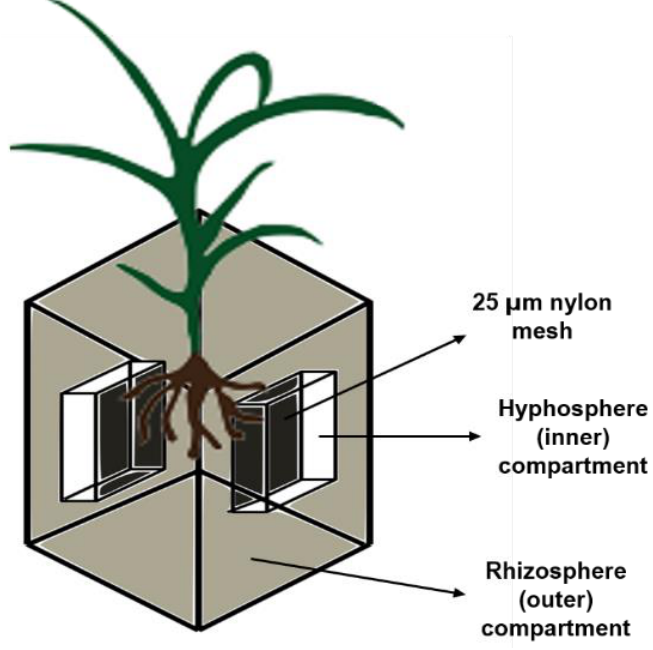
Figure 1. Diagram of the designed microcosm having rhizosphere and hyphosphere compartments separated by a nylon